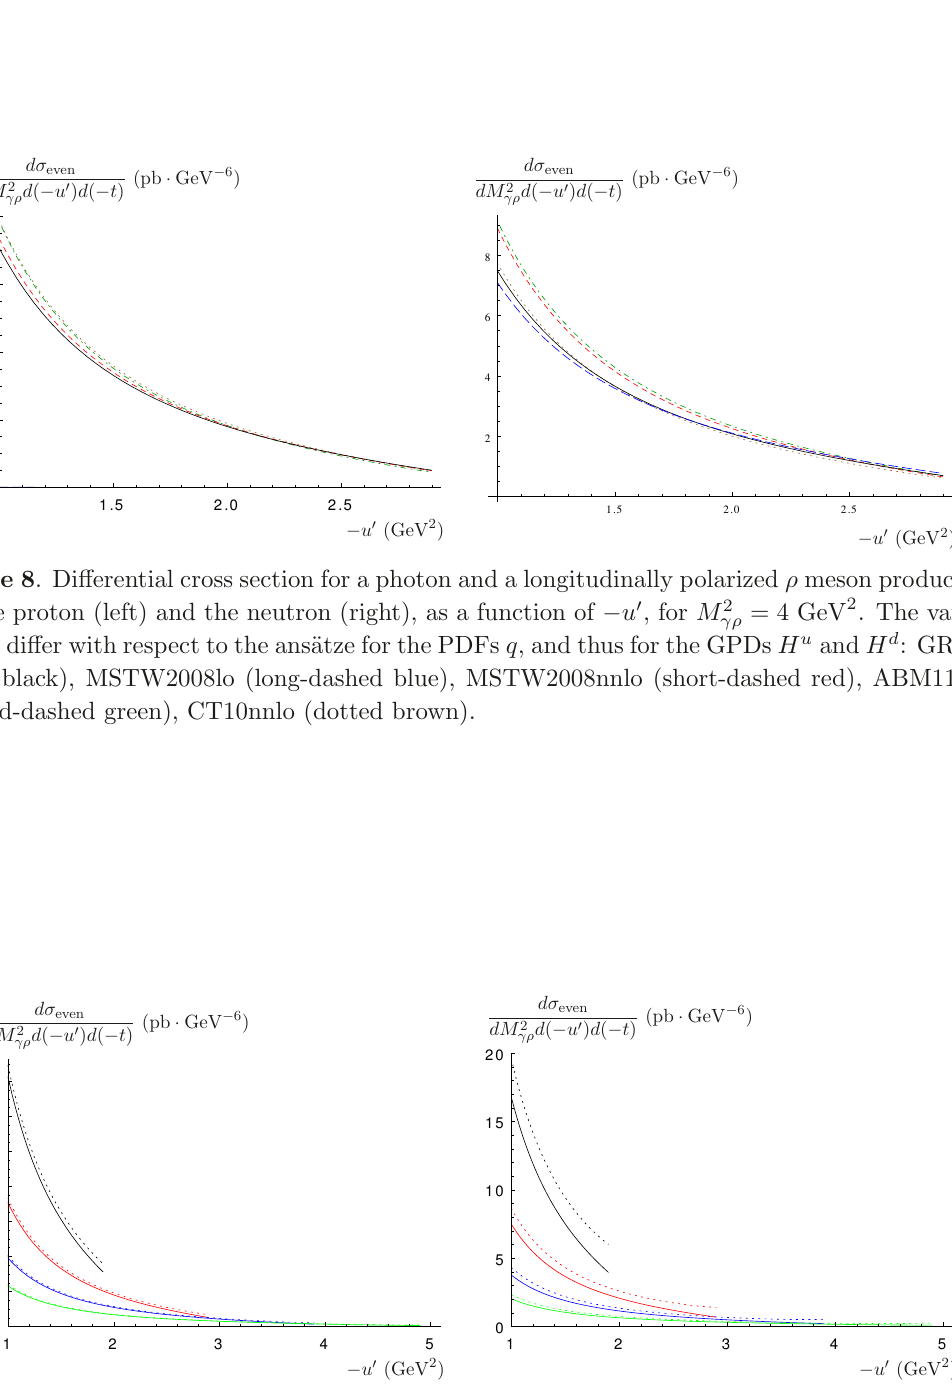
= 3 , 4 , 5 , 6 GeV 2 (resp. γρ